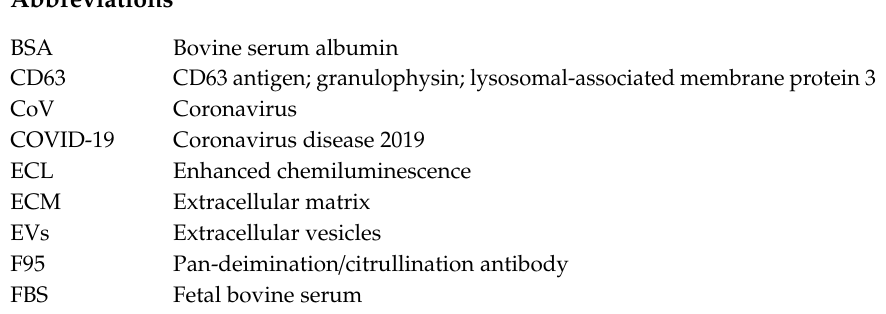
Table S1. Full LC-MS / MS analysis of F95-enriched proteins in bovine serum. Supplementary Table S2. Full LC-MS / MS analysis of F95-enriched proteins in bovine